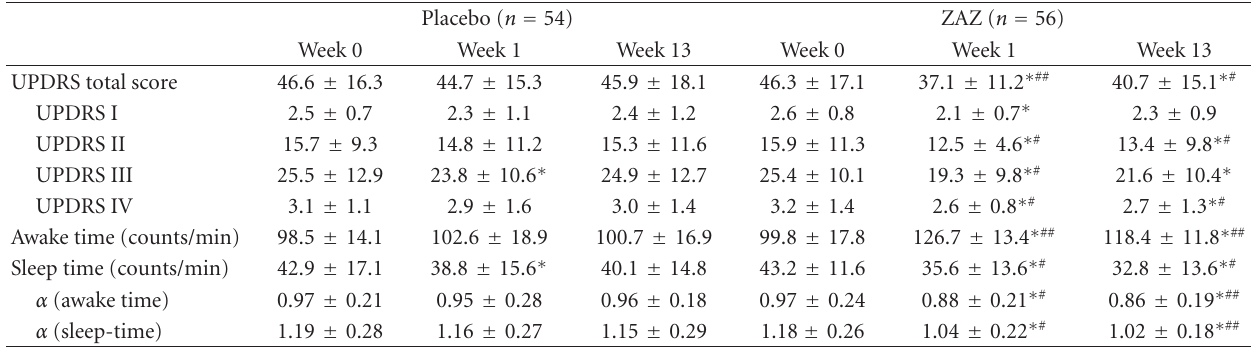
Table 2: Results of clinical evaluation between before and after test granule